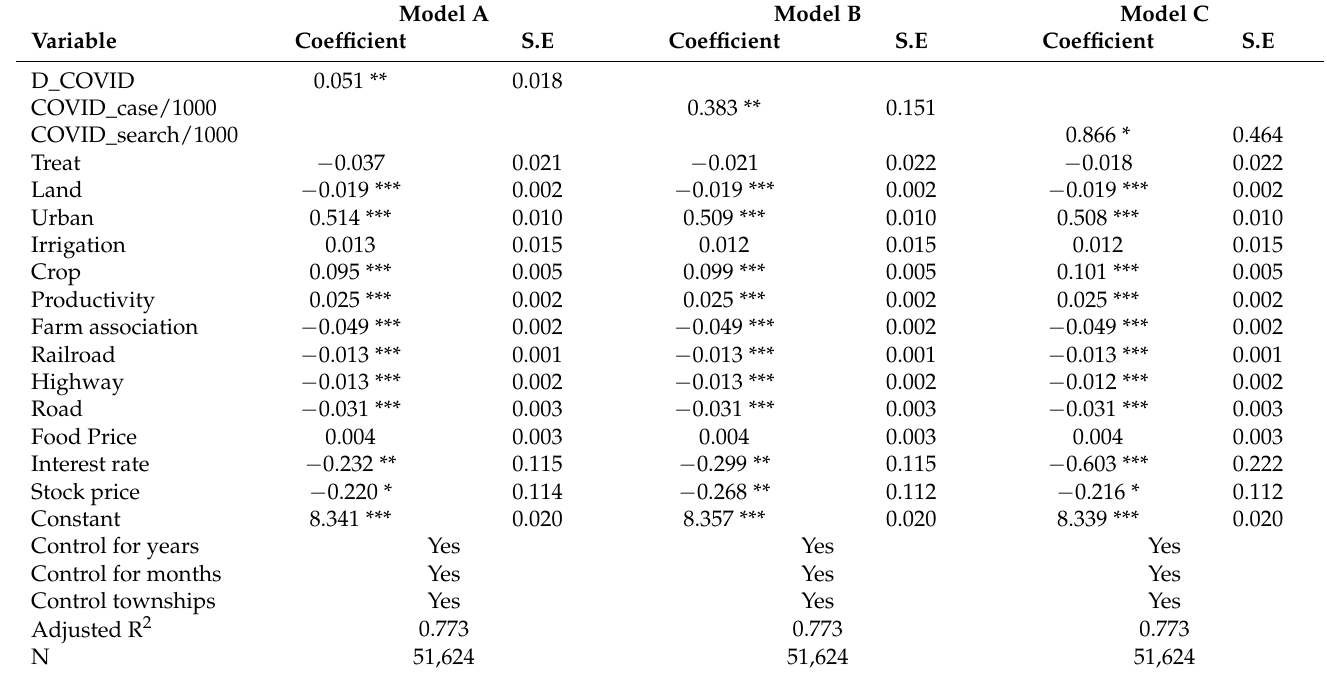
Table 3. Estimation of the farmland price equations (in